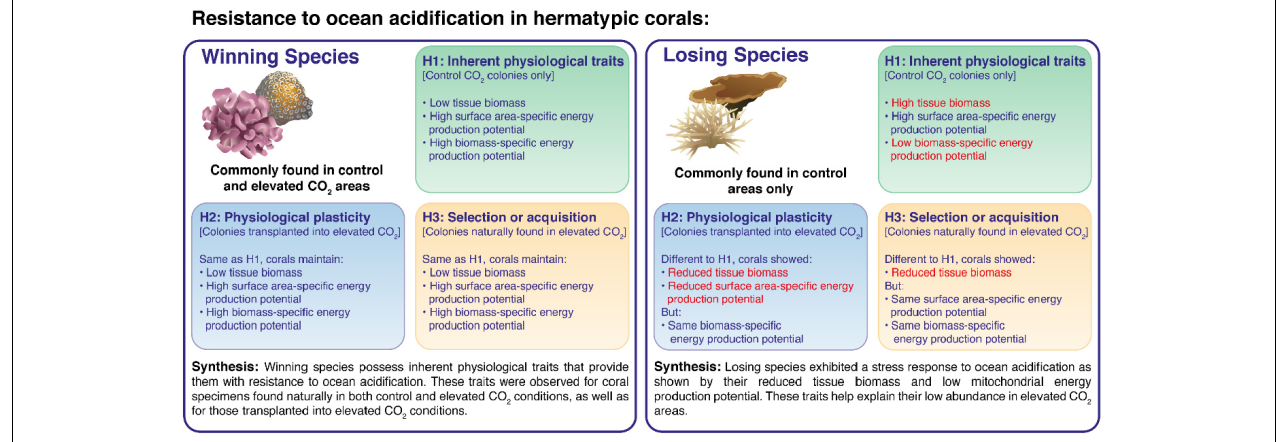
FIGURE 5 | Synthesis and interpretation of the main results for hypothesis (1) Inherent physiological traits of coral species resistant to ocean acidification: Physiological traits of corals in control areas, Hypothesis (2) Physiological plasticity as an acclimation response to ocean acidification: Physiological traits of corals transplanted from control areas into control and elevated p CO 2 areas, and Hypothesis (3) Selection or acquisition of resistance to ocean acidification: Physiological traits of corals found naturally in both elevated p CO 2 and control areas.